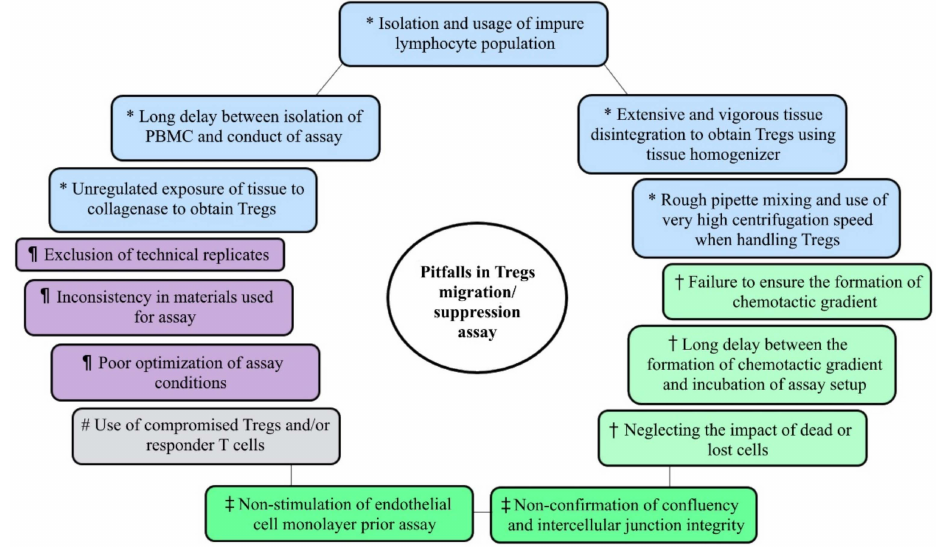
Figure 2. Some notable pitfalls in ex vivo human regulatory T cell migration and suppression